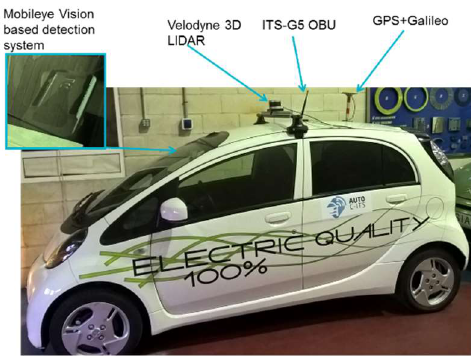
Figure 4. Detail of the INSIA automated vehicle used in the validation of the C-ITS Architecture.